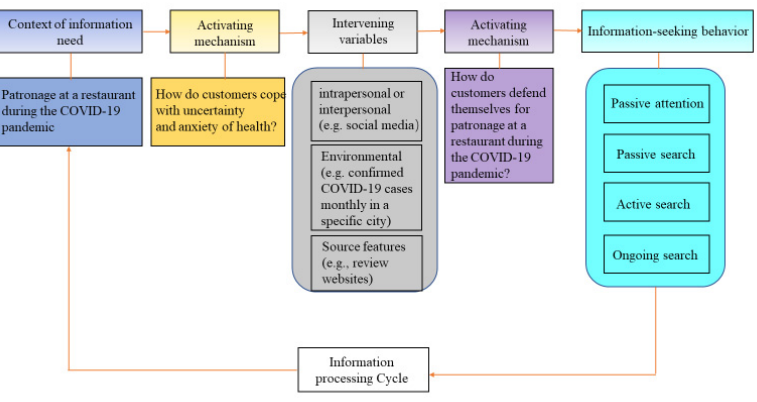
Figure 1. Revised Wilson’s model of information behavior.